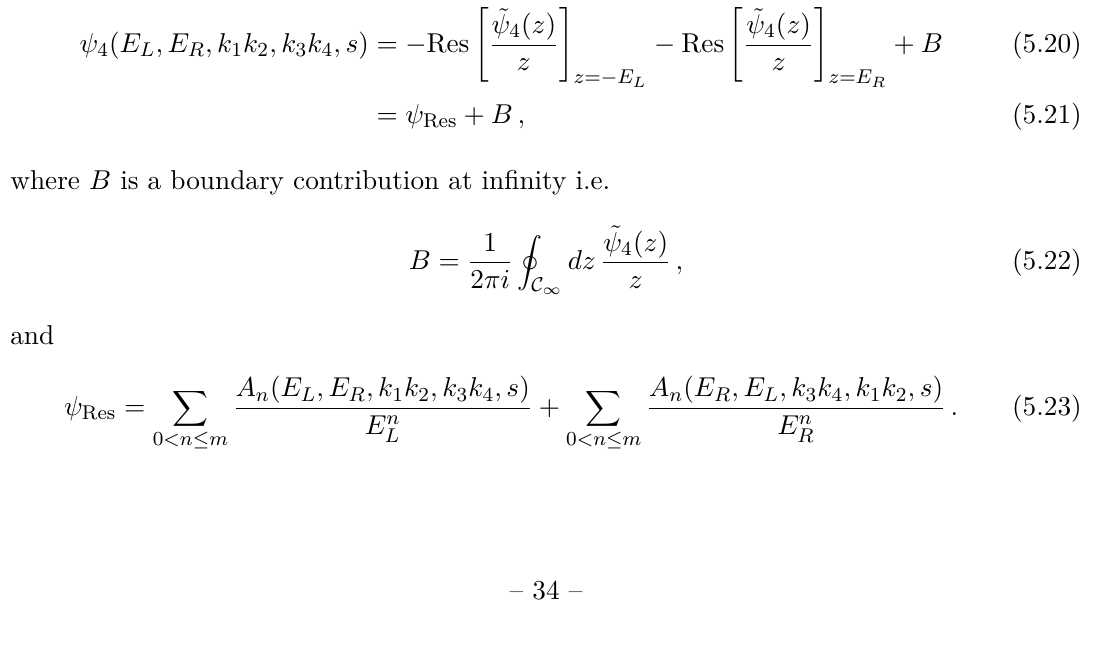
Figure 3 . The countour integrals adopted for relating the value of and an associated boundary term at